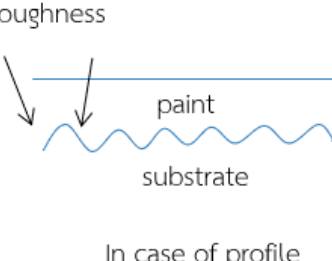
Figure 2. comparison between surface with profile and without